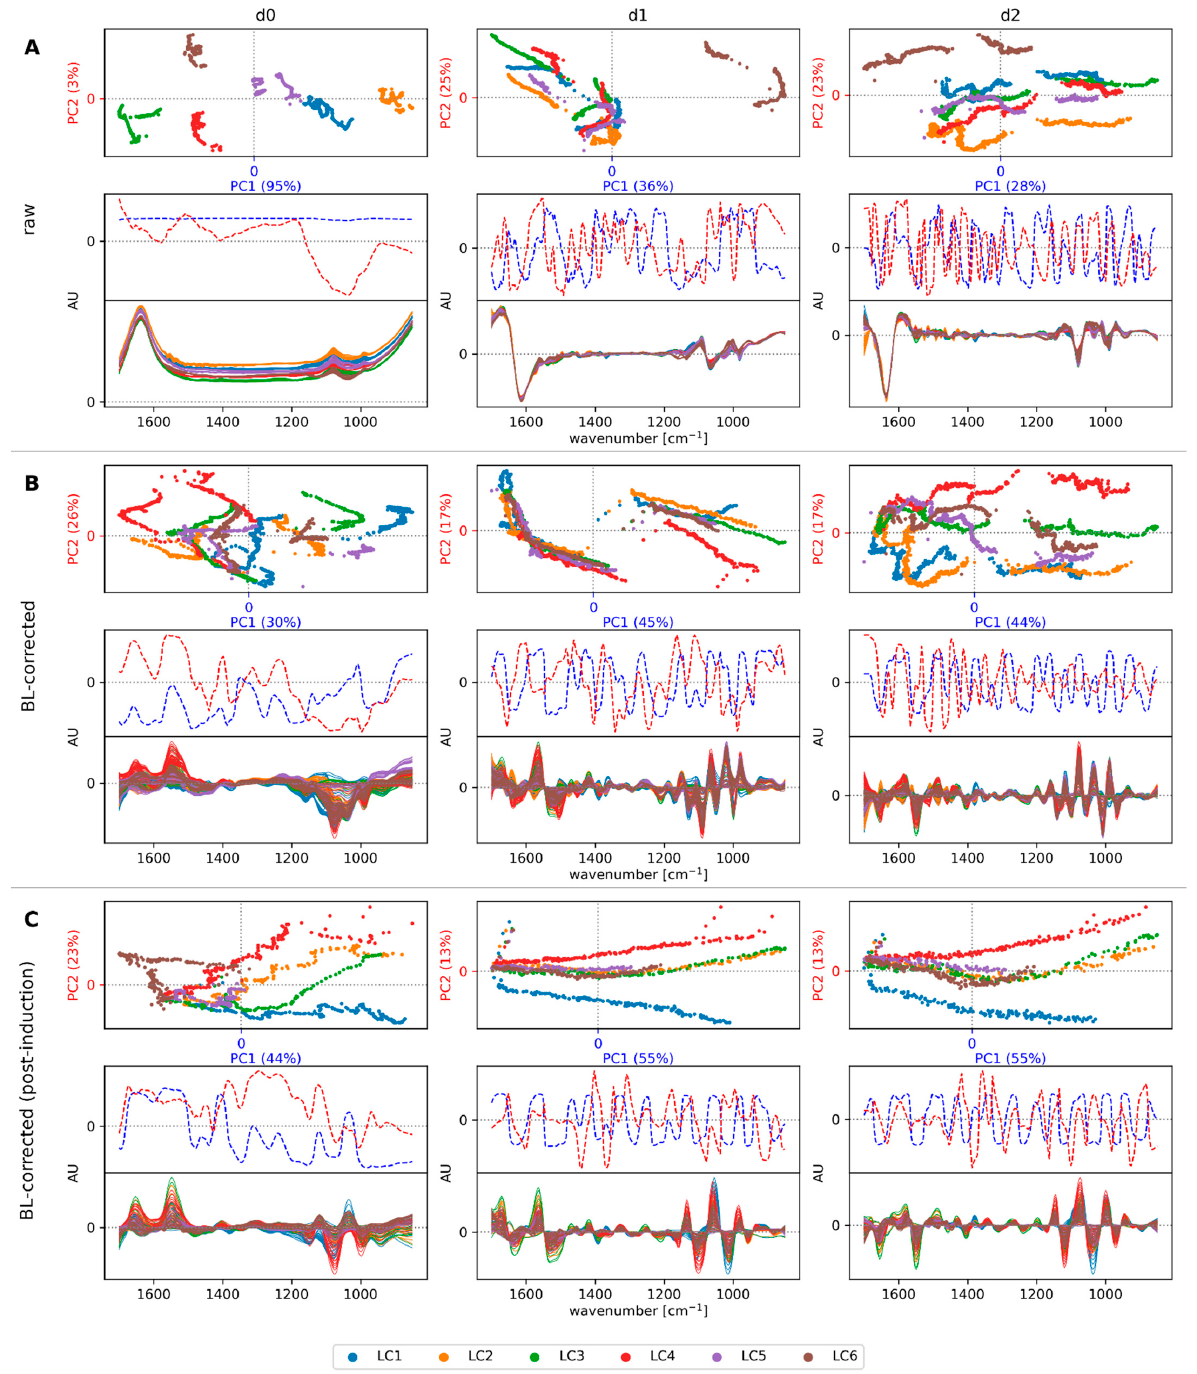
Figure 4. Principal component analysis (PCA) of raw spectra ( A ), baseline (BL)-corrected spectra ( B ), and BL-corrected post-induction spectra ( C ). The left column contains undifferentiated spectra (d0), the center column first-derivative spectra (d1), and the right column second-derivative spectra (d2). The top panel of each sub-figure ( A – C ) shows the PCA scores with the percentage of variance explained by the respective principal component given in parentheses. The center panel shows the PCA loadings, and the bottom panel the IR spectra. Colors represent the different runs.